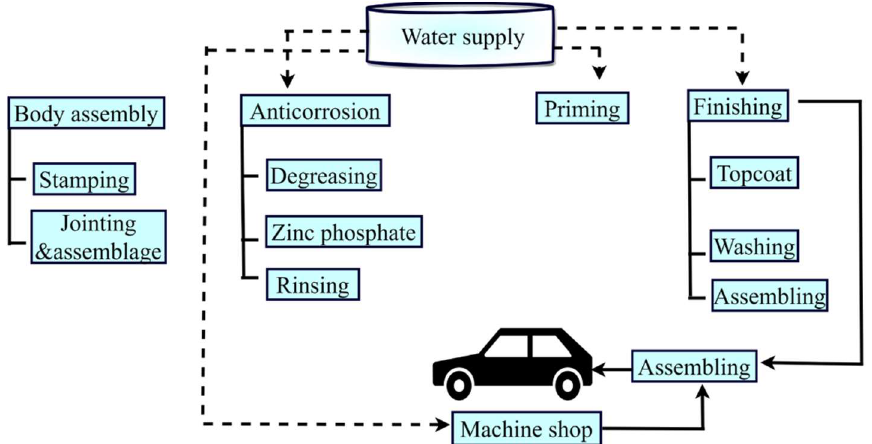
Figure 6. Representation of automobile production process.